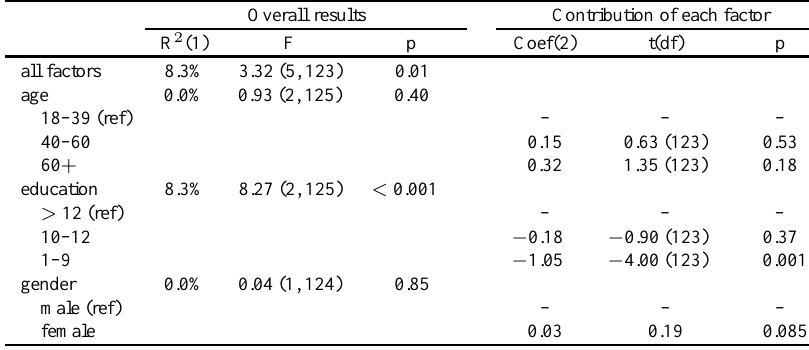
Table 2 Predictors of the auditory comprehension subtest Overall results